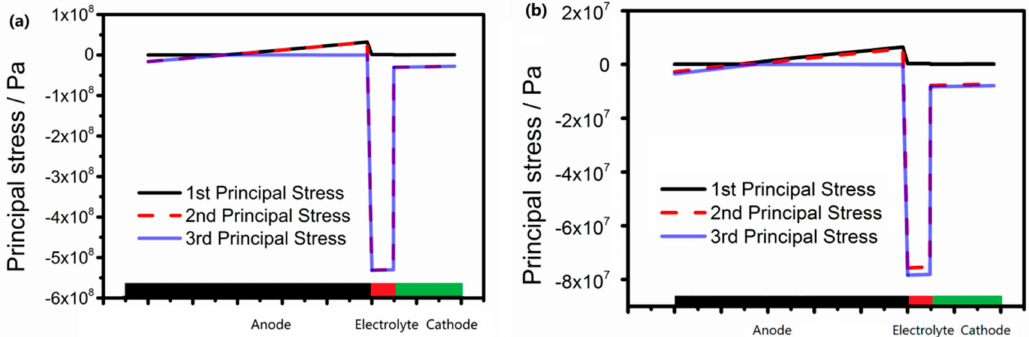
Figure 1. Principal stress distribution in the anode-electrolyte-cathode assembly: ( a ) at the room temperature (RT); ( b ) at 973 K